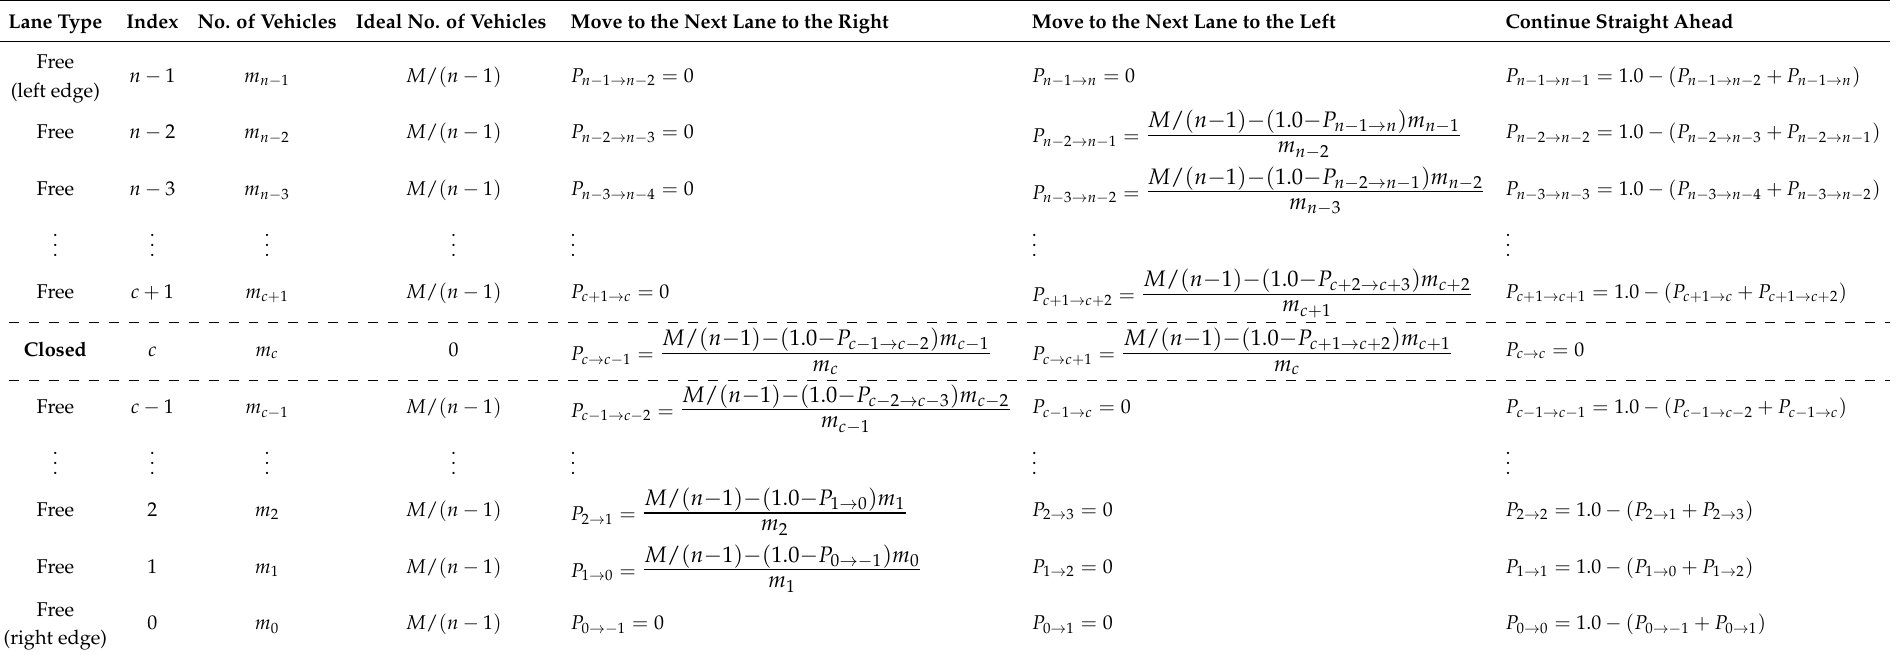
Table 1. Movement probabilities in n-lanes when lane c is closed.